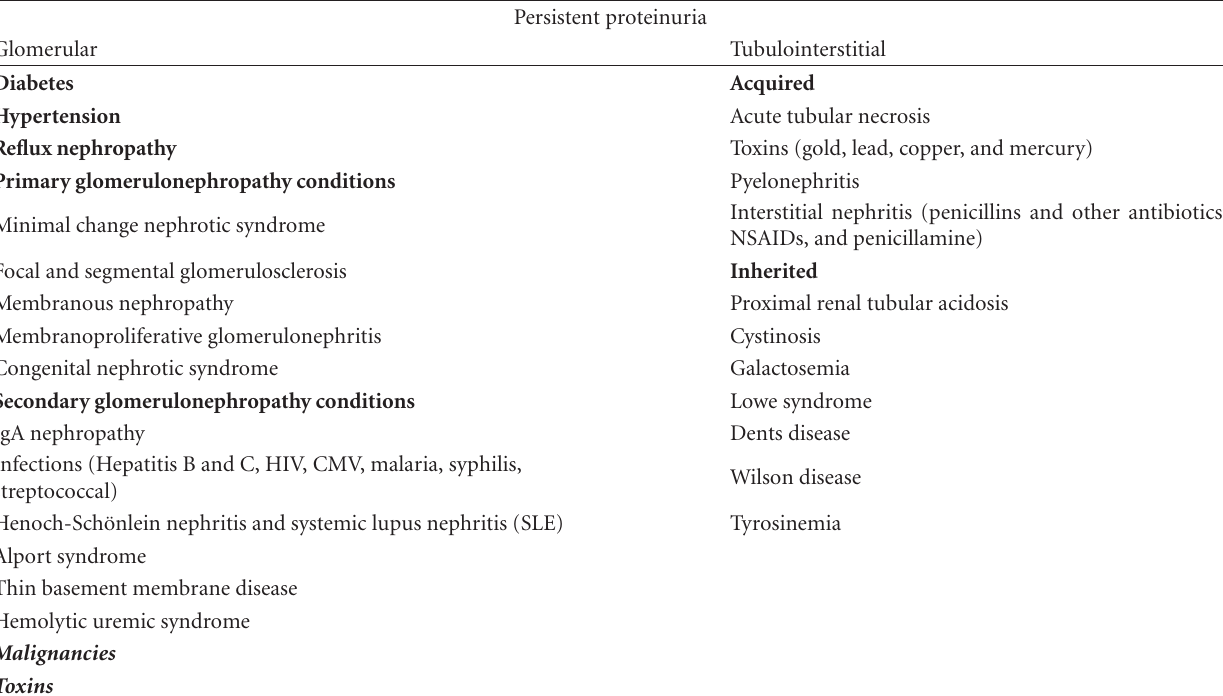
Table 1: Causes of persistent